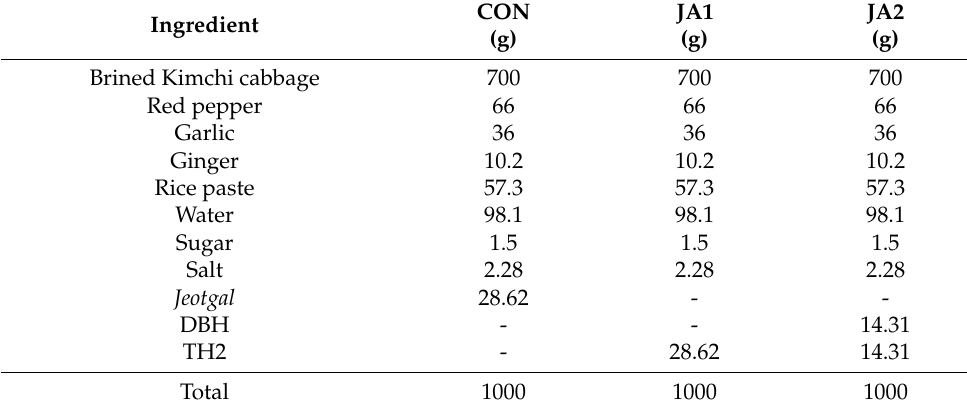
Table 3. Ingredients used to prepare kimchi with commercial and jeotgal